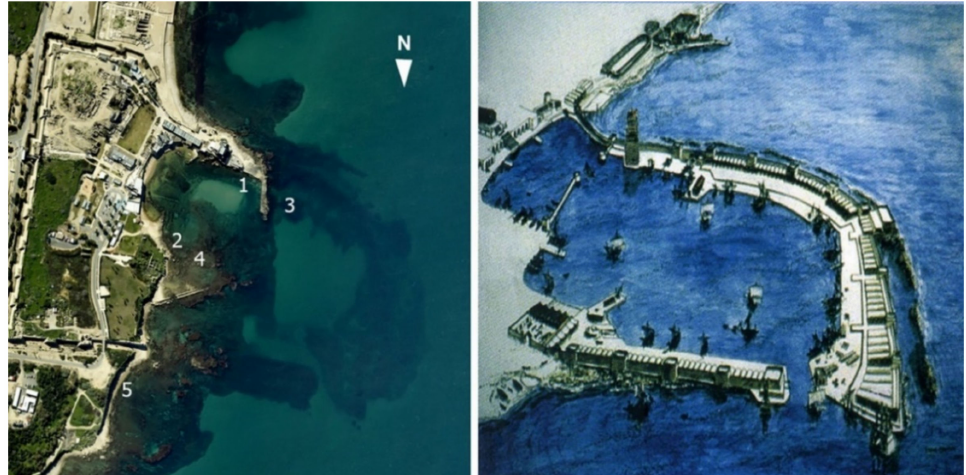
Figure 4. The Roman, Herodian harbor of Caesarea: left panel—aerial photo, right panel—artist reconstruction [43]. (1) Roman dock; (2) Roman dock; (3) submerged surface built of ashlars; (4) Cru- sader mole; (5) Beachrock